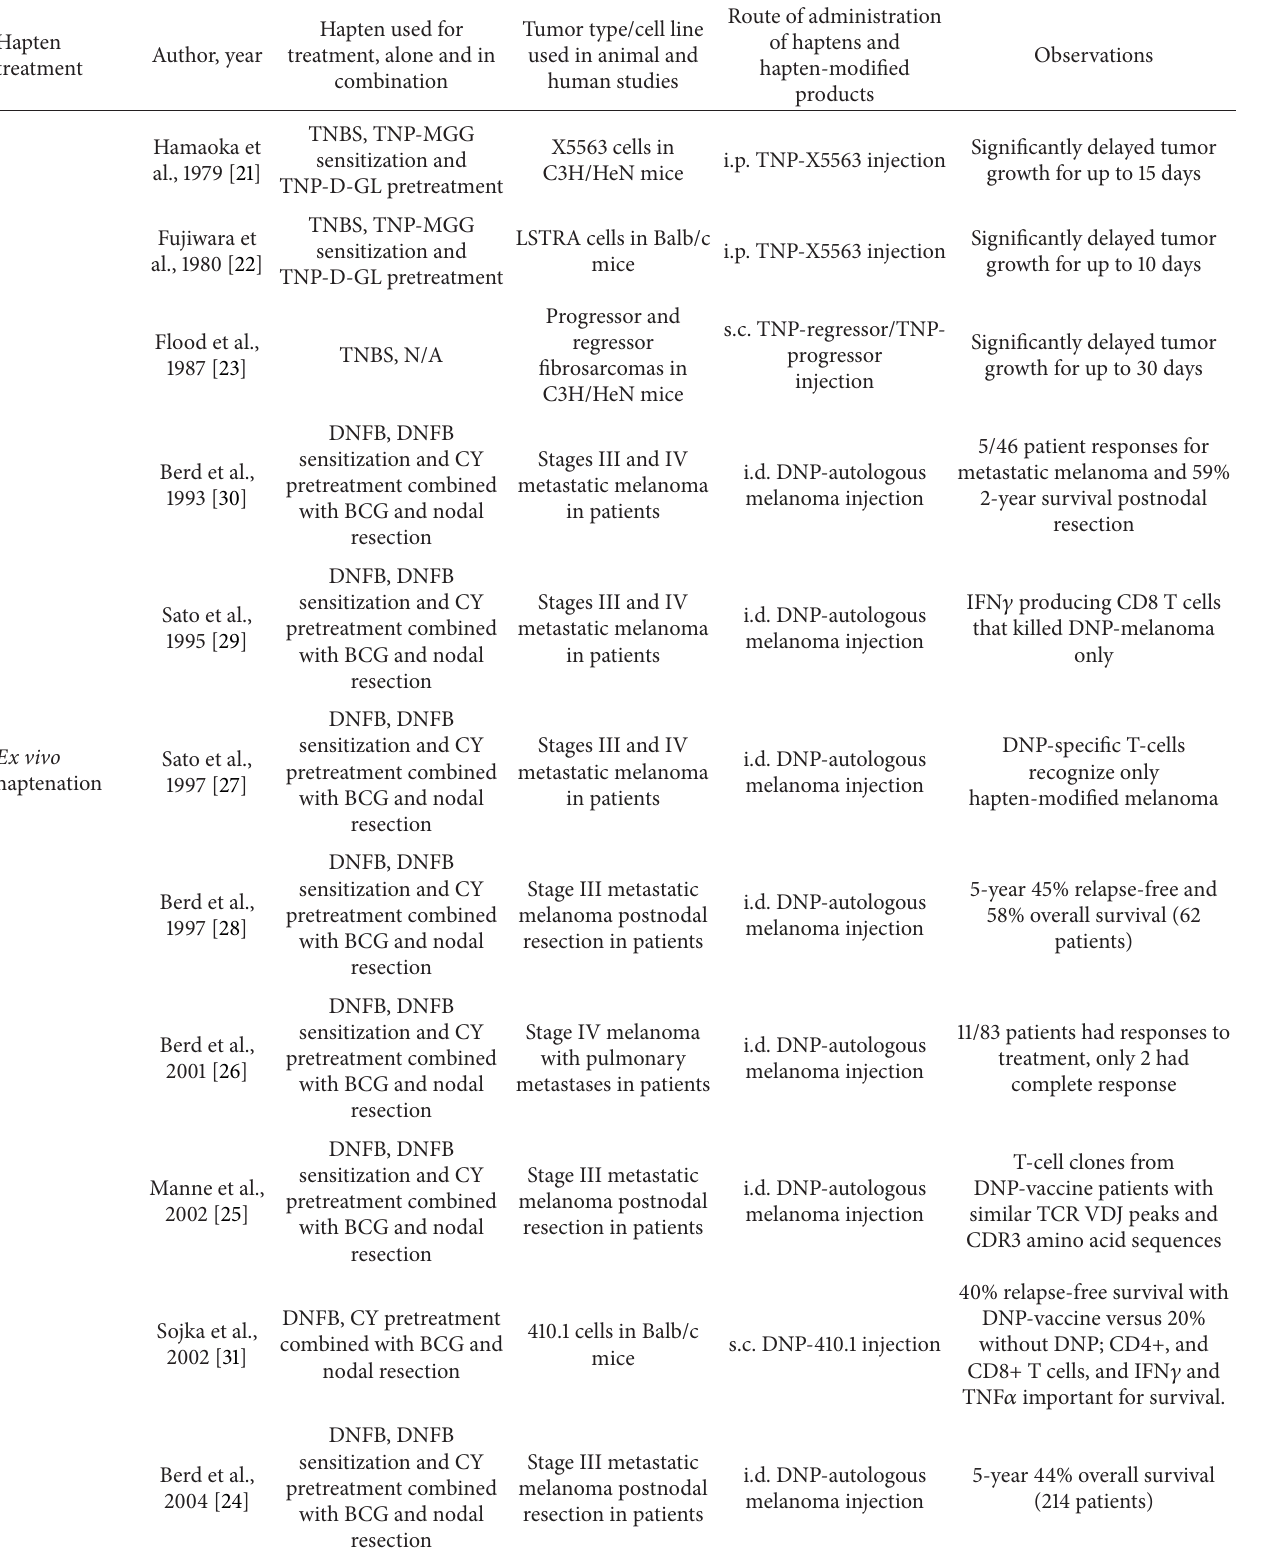
Table 1: Summary of the hapten-mediated tumor regression